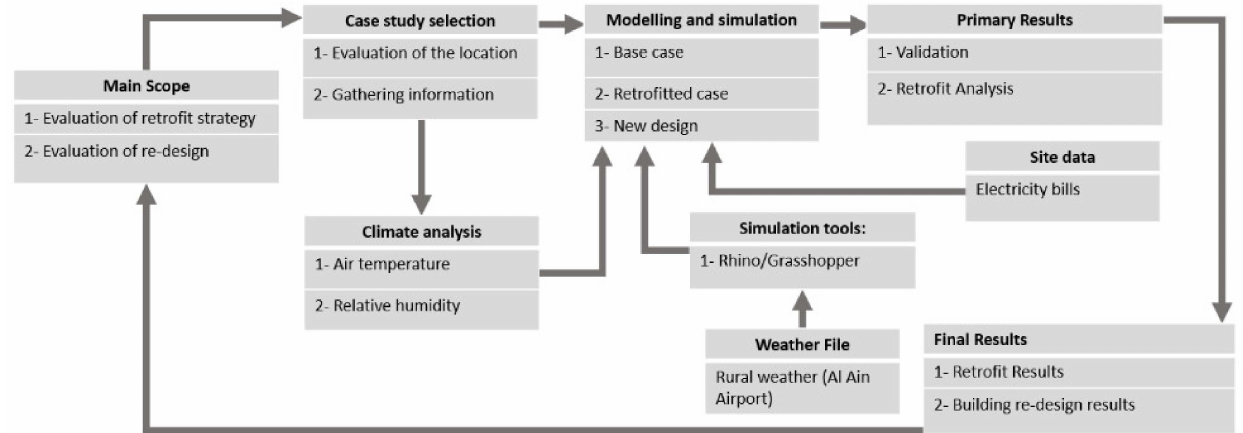
Figure 1. Methodology schematic